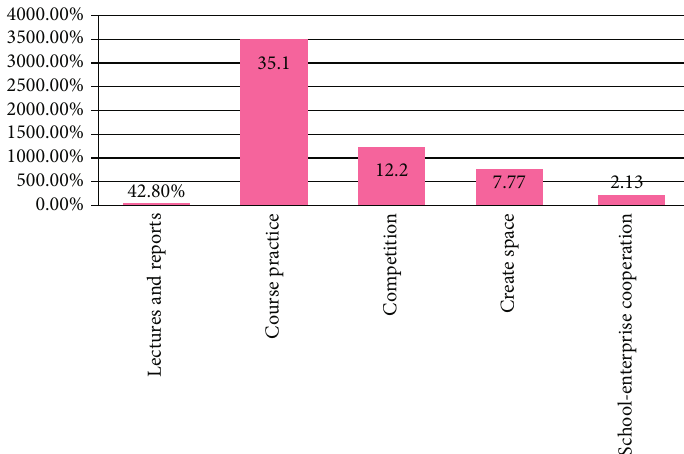
Figure 2: Social practice of innovation and entrepreneurship education for college